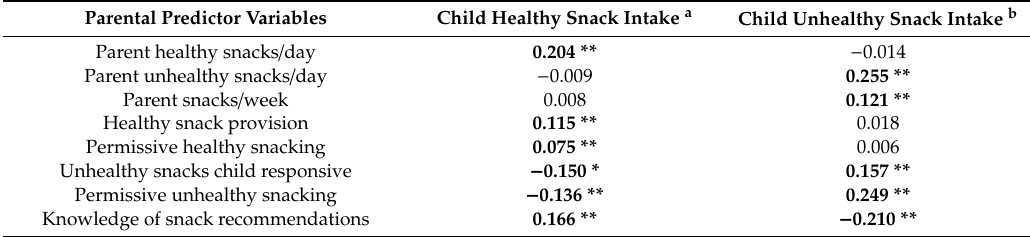
Table 5. Correlations (Pearson’s r) between parent snacking practices and child snacking behaviour. Parental Predictor Variables Child Healthy Snack Intake a Parent healthy snacks /